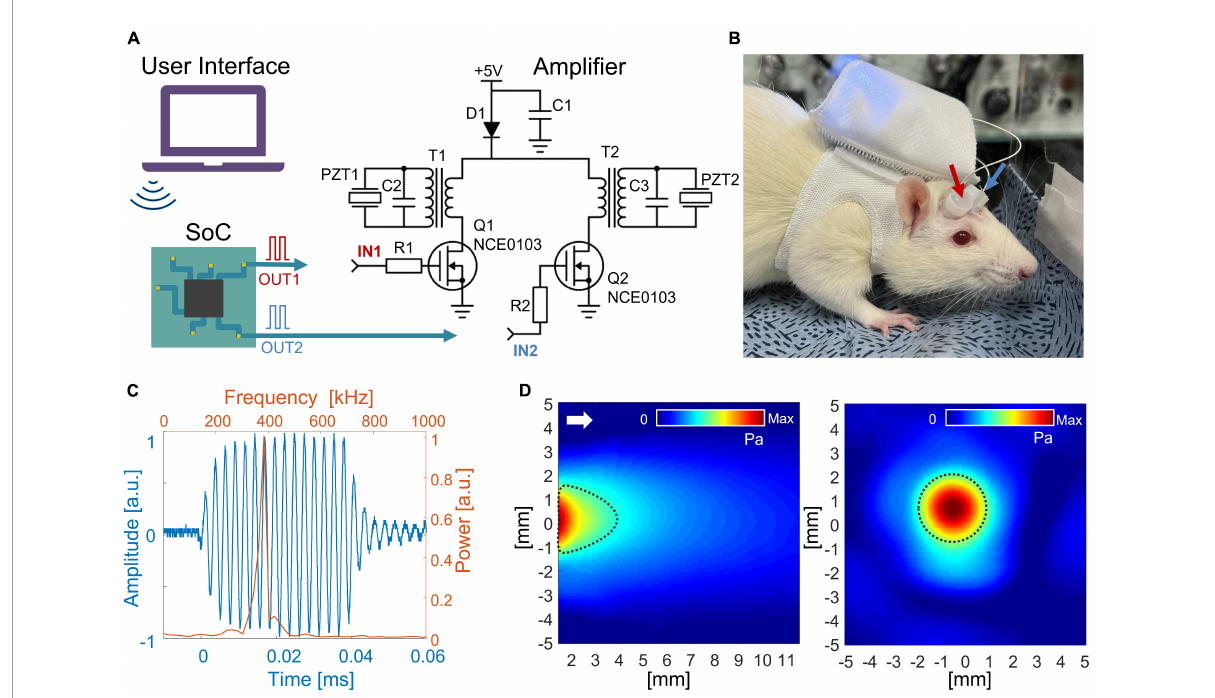
FIGURE1 (A) Schematic diagram of the wireless LIPUS system. A system on a chip (SoC) generates PWM signals that are further converted to 380 kHz sine waves to feed ultrasound transducers (PZTs). R1 = R2 = 100 (cid:127) ; C1 = C2 = C3 = 100 uF; D1 – SS14. (B) The entire system fits inside a backpack that was worn by an awake rat. The arrows indicate ultrasound transducers. (C) An acoustic waveform with a central frequency of 380 kHz was generated from the LIPUS system. The time and frequency domains are shown as blue and orange color, respectively. (D) The acoustic beam profile of the in-house built transducer was measured in a free water condition. The longitudinal pressure map is on the left, and the transverse profile is on the right (measured 2 mm away from the transducer surface). The full width at half-maximum (FWHM) of pressure is indicated with dotted black lines. The white arrow shows the direction of